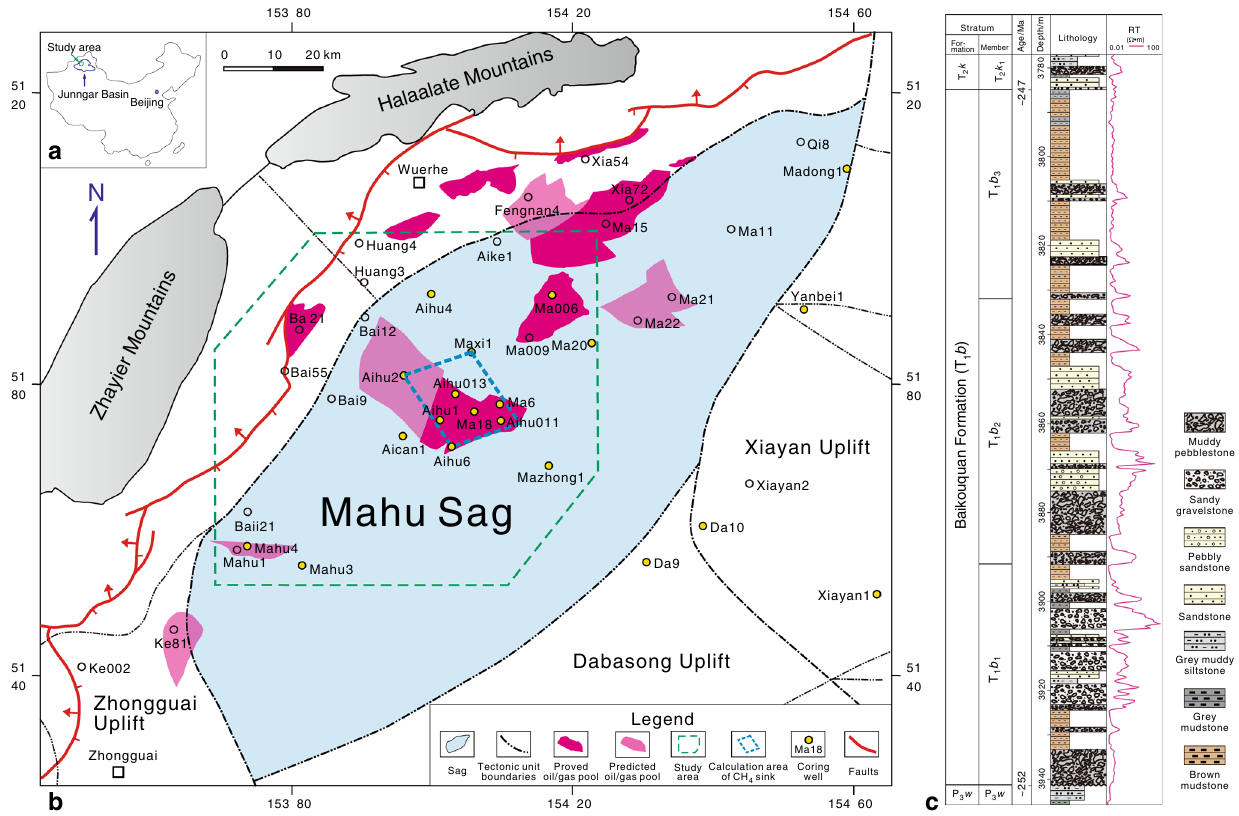
Fig. 1 Schematic geologic map of the Mahu Sag, and generalized stratigraphy of the Lower Triassic Baikouquan Formation. a The location of the Junggar Basin in China. b The study area is located in the west slope of the Mahu Sag adjacent to the northwestern marginal thrust faults of the Junggar Basin. c The sun-shape symbols within the Resistivity logging column indicate reservoir beds rich oil and